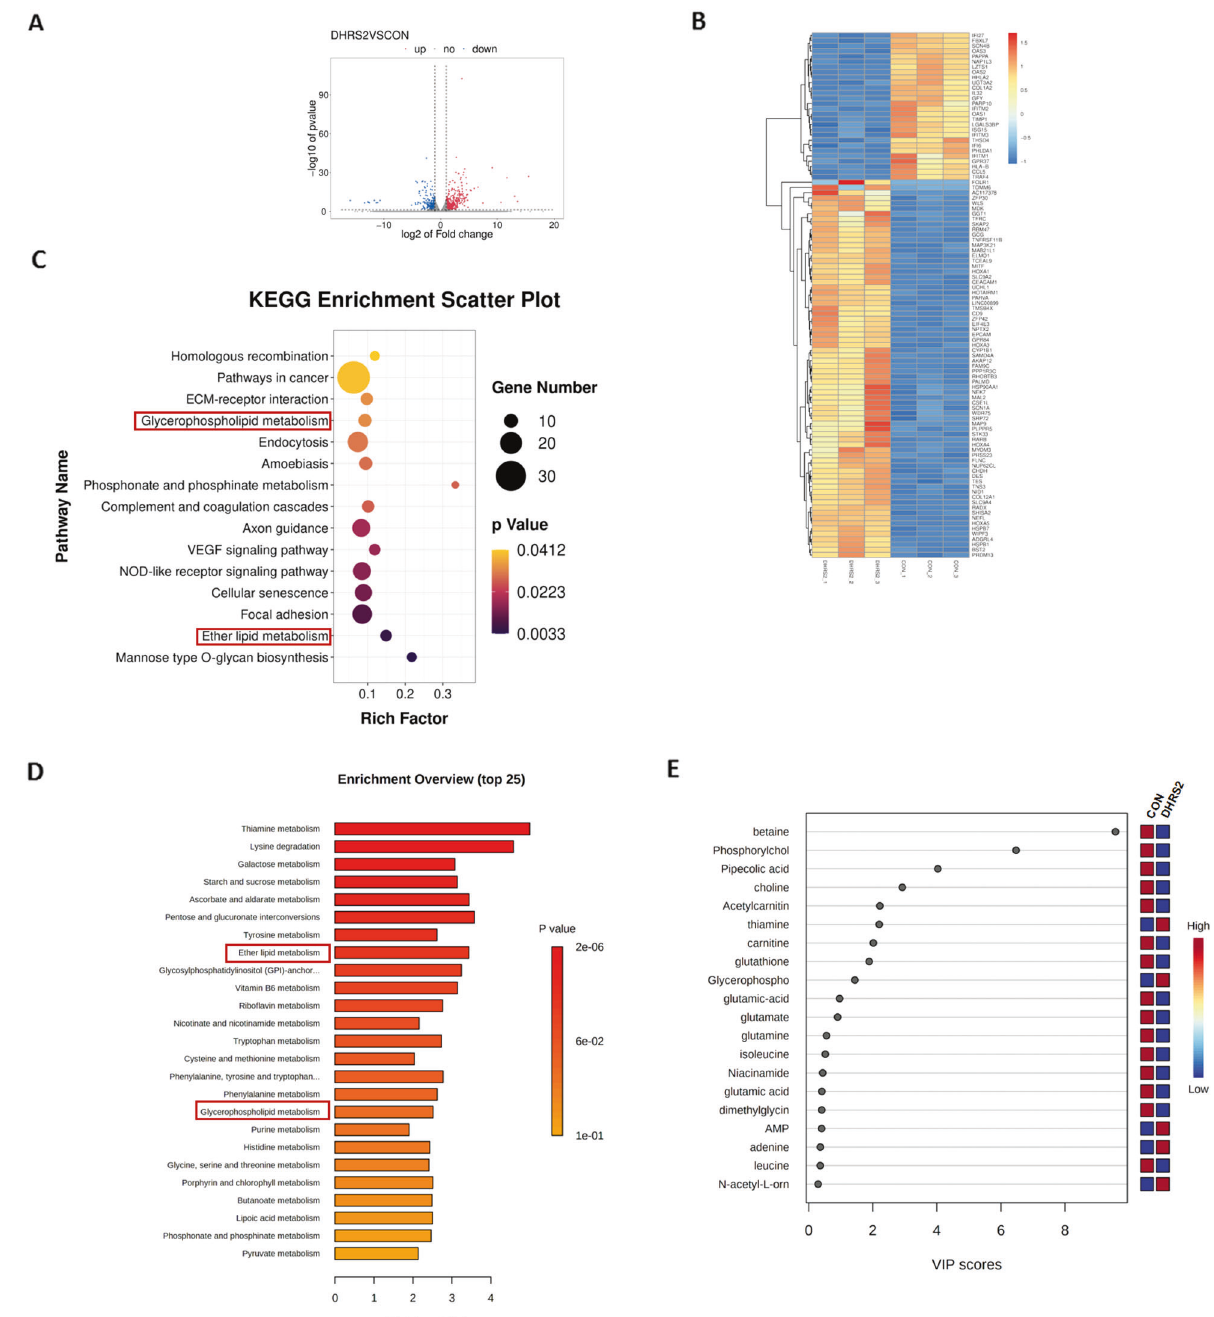
Fig. 2 Combination of transcriptome and metabolome reveals the interruption of choline metabolism by DHRS2. A Scatter plots of all expressed genes in OVCAR3-CON and OVCAR3-DHRS2 cells. Blue color indicates upregulated genes, red indicates downregulated genes, and gray indicates non-regulated genes. The ‘ regulated gene ’ is de fi ned as a gene with FDR ≤ 0.001 and abs (log2(Y/X)) ≥ 1. B Heatmap of the transcriptome changes in OVCAR3-CON and OVCAR3-DHRS2 cells ( n = 3 for each group). C Enriched KEGG pathway analysis in the transcriptome of OVCAR3-CON and OVCAR3-DHRS2 cells. D Pathway enrichment analysis in the metabolome of OVCAR3-CON and OVCAR3- DHRS2 cells. E Important features identi fi ed by partial least squares-discriminant analysis (PLS-DA). The colored boxes on the right indicate the relative concentrations of the corresponding metabolite in OVCAR3-CON and OVCAR3-DHRS2